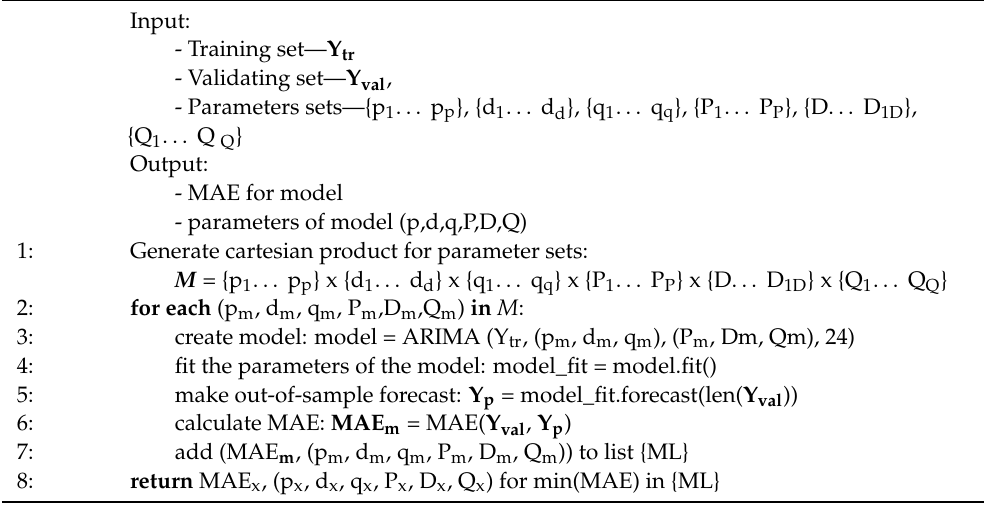
Algorithm 1: Grid search parameters of the SARIMA